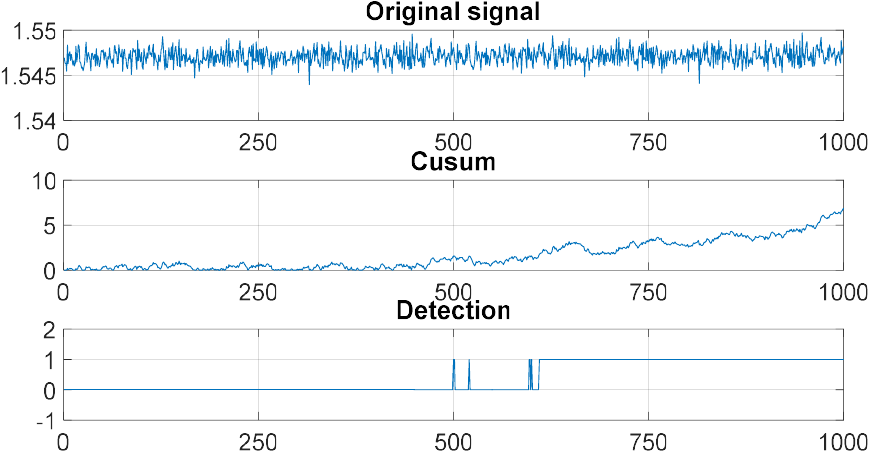
Energies 2019 , 12 , x FOR PEER REVIEW Figure 11. Fault detection results with the mean value. Figure 11. Fault detection results with the mean value.